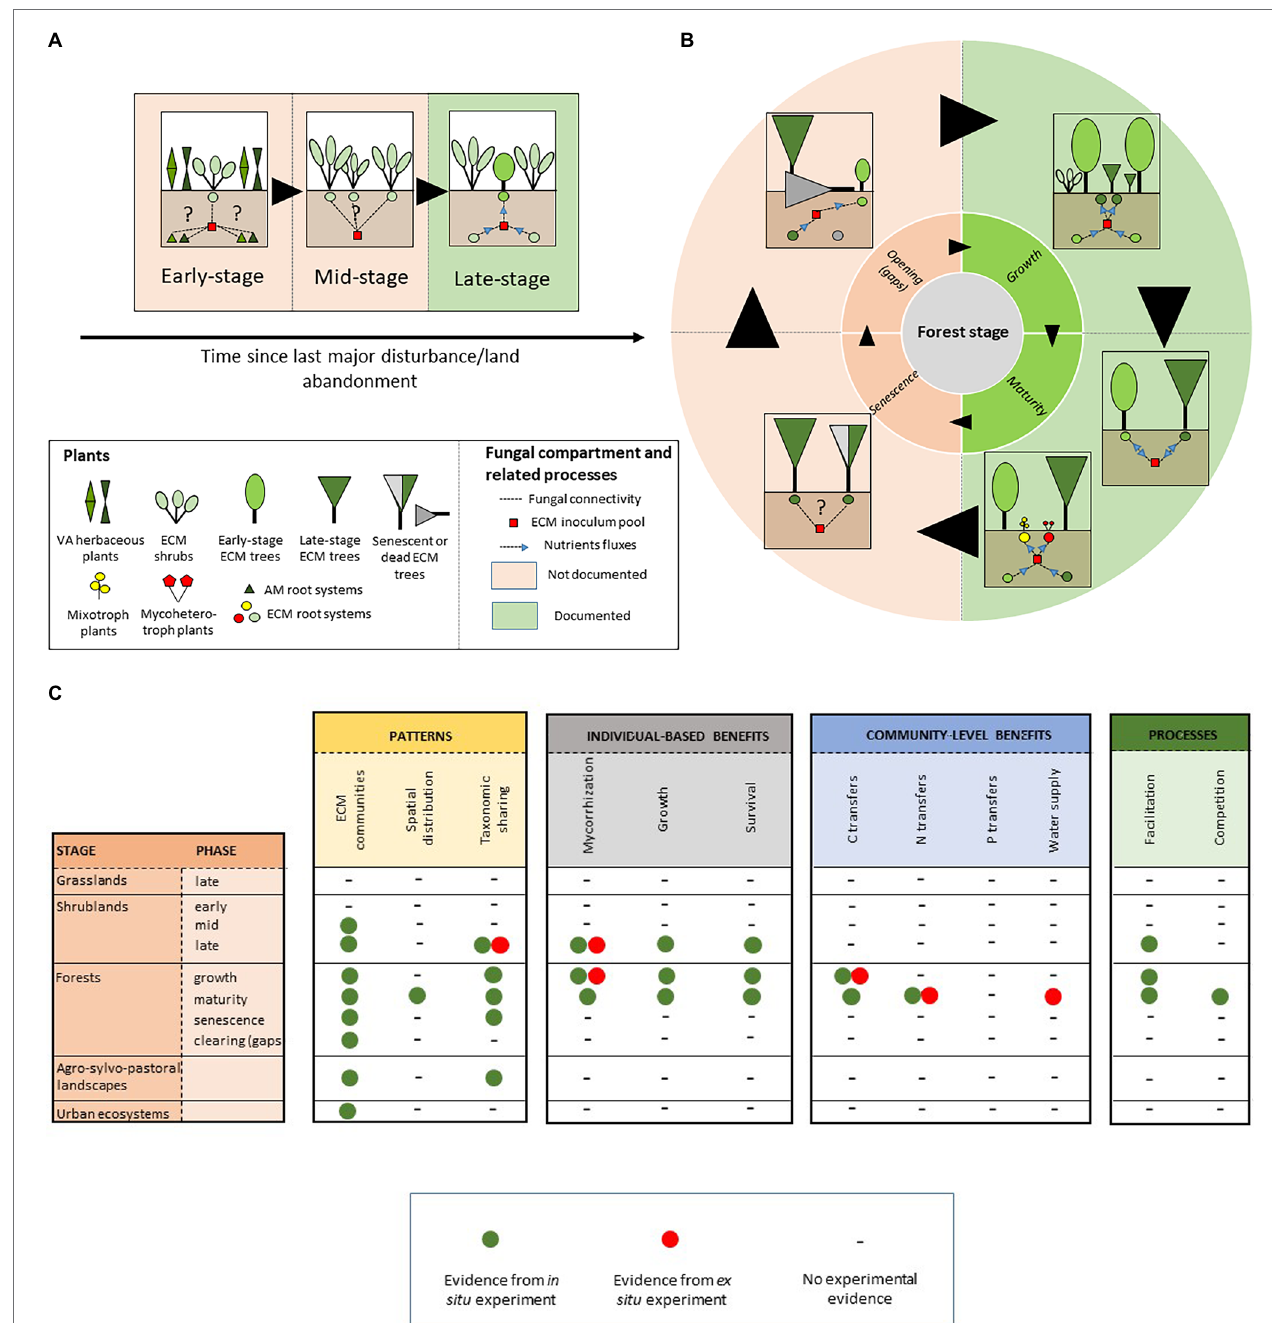
FIGURE 1 | Schematic representation of ectomycorrhizal-based networks (A) across early ecological succession and (B) during sylvigenetic cycle. Dashed lines indicate plant–plant interactions through ECM CMNs. Blue arrows indicate nutrient transfers through ECM CMNs. (C) Summary of ECM network-related effects documented along the